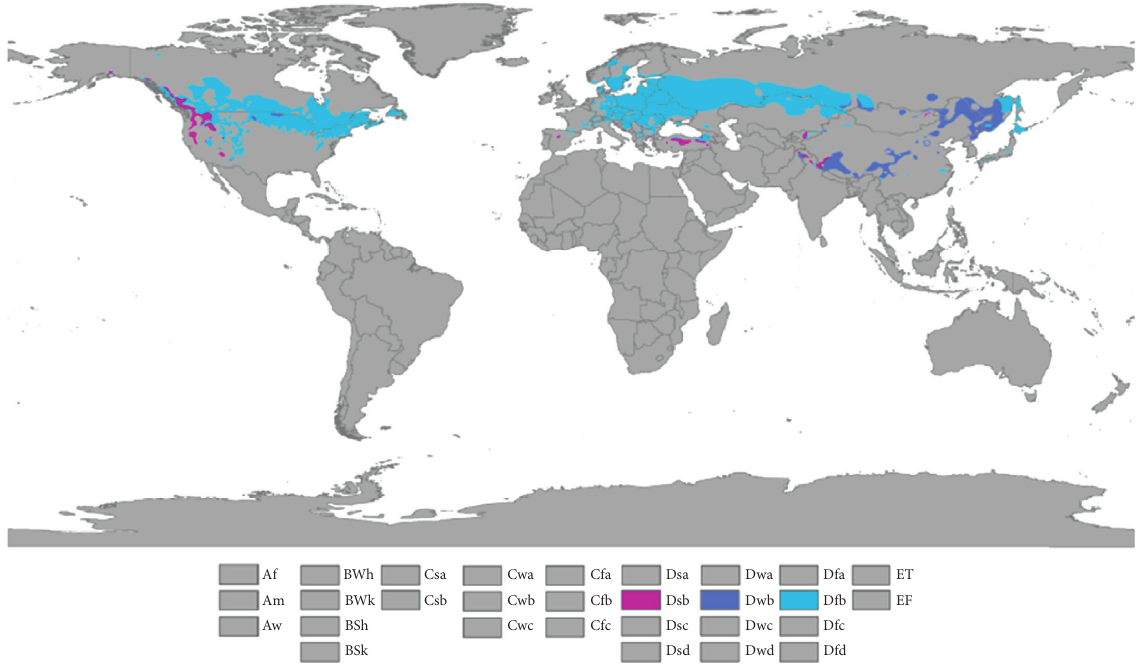
Figure 1: Map of the world according to K¨oppen–Geiger climate classification (Dfb is in light blue). Table 1: Details of the selected cities in Dfb climate